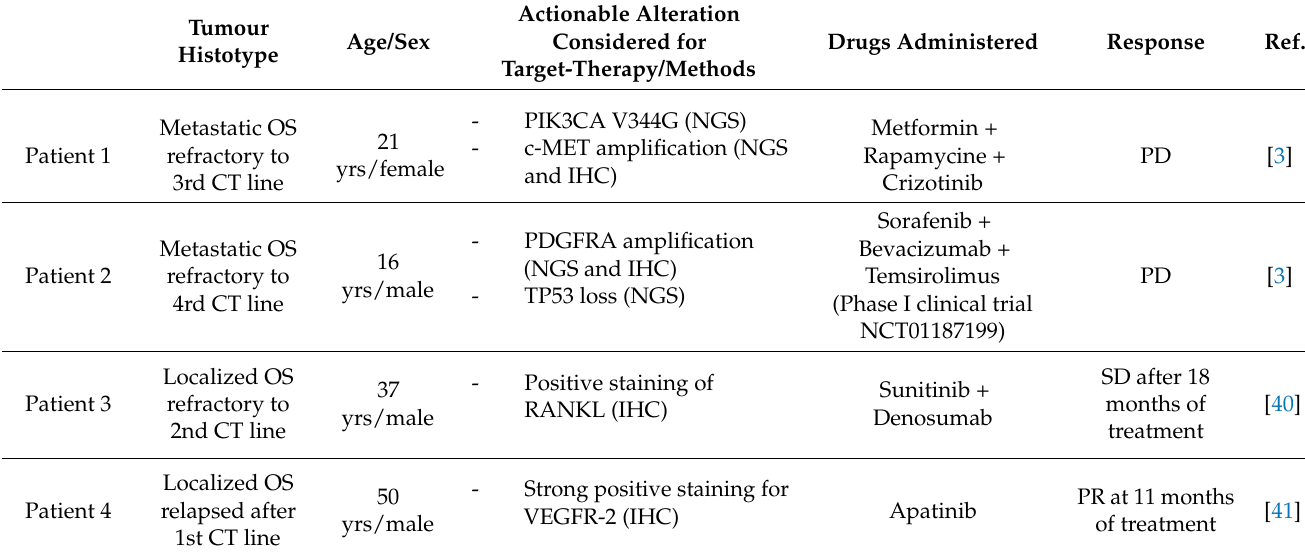
Table 2. Case-reports reported in literature of OS patients treated with a matched targeted drug on the basis of their tumour molecular